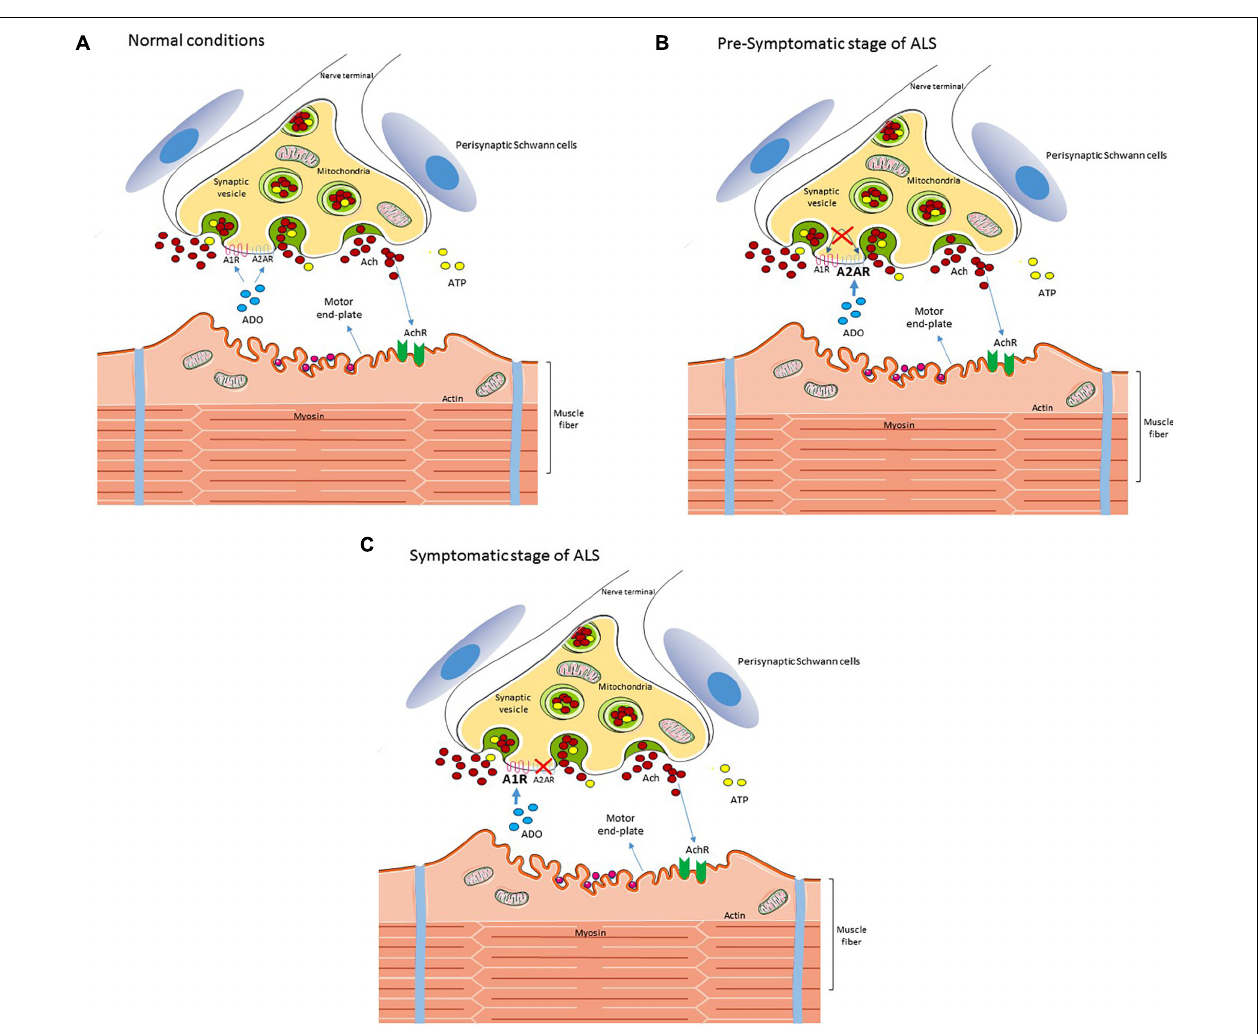
FIGURE 1 | Schematic diagram of the reported changes in adenosine signaling at the neuromuscular junction in an ALS mice model. In wild type (A) neuromuscular junctions, adenosine activates both inhibitory A 1 R and excitatory A 2A R, modulating acetylcholine release from motor nerve terminals. In ALS mice at the pre-symptomatic stage (B) there is a loss of A 1 R/A 2A R functional cross-talk at the neuromuscular junction and the excitatory action of A 2A R is exacerbated. At the symptomatic stage (C) there is an increase of A 1 R tonic activation, which may be contributing to neurotransmission failure on late disease stages, whereas the excitatory action of A 2A R disappears. For details see Nascimento et al. (2014, 2015). Perisynaptic Schwann cells contribute to the pool of ATP at the synaptic cleft but ATP signaling in these cells seems unchanged in ALS, in contrast with mACh signaling (Arbour et al., 2015). Interestingly, the exacerbated A 2A R signaling at the pre-symptomatic stage correlates with an enhanced release of ACh from nerve terminals and with signs of dysregulated calcium buffering at motor nerve endings (Rocha et al., 2013; Arbour et al.,